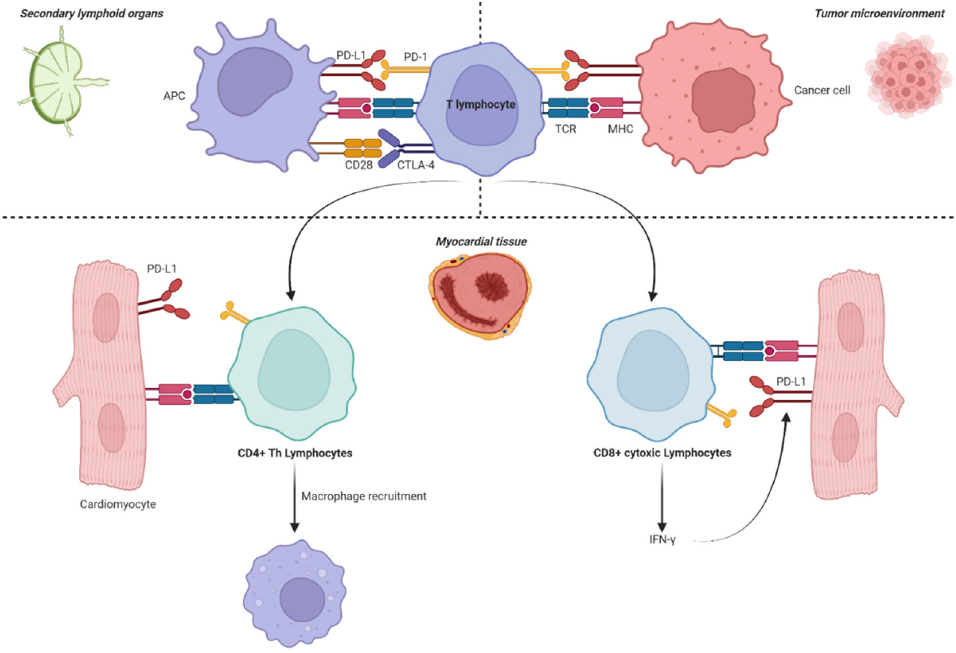
Figure 1. The CD8+, CD4+ T cells, and macrophages interplay within the pathogenesis of ICI-related cardiotoxicity.